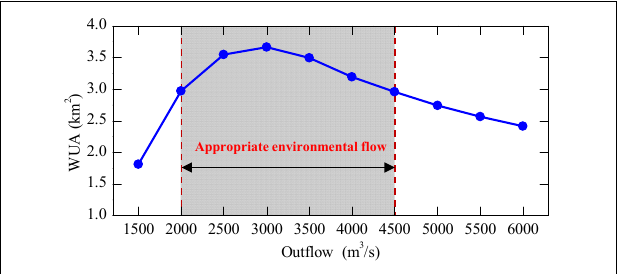
FIGURE 8 | Outflow-weighted usable area (WUA) relationship derived from the physical habitat simulation model (PHABSIM).